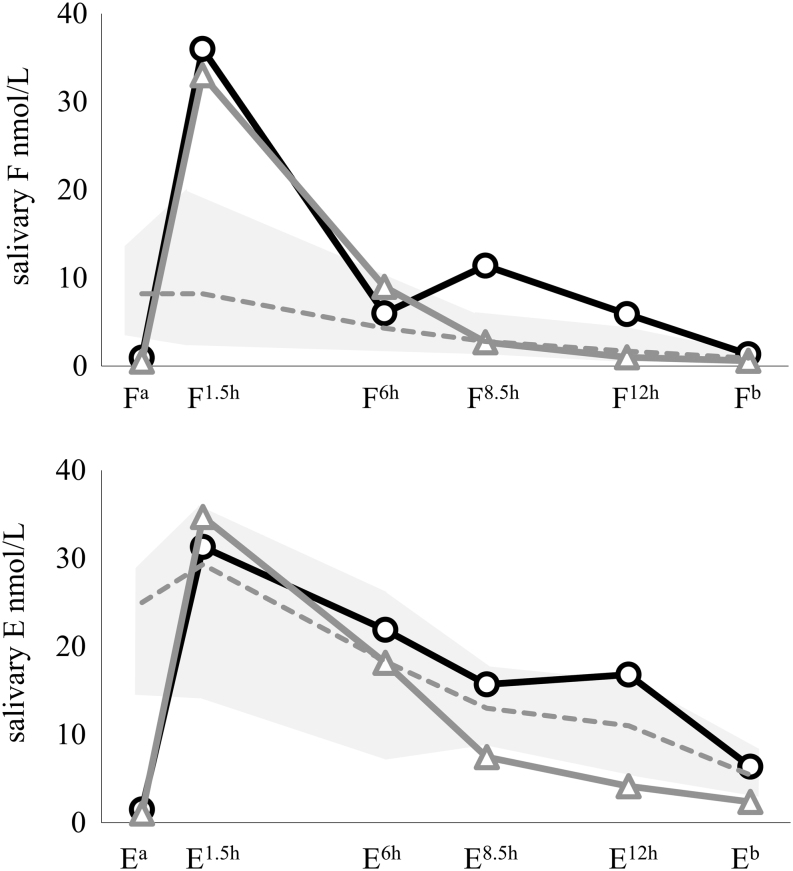
Salivary cortisol (F) and cortisone (E) rhythm in patients with conv-HC (black line) and DR-HC (grey solid line), compared to healthy controls (grey area is included between the 10th and 90th percentile of controls, dotted grey line represents the median).